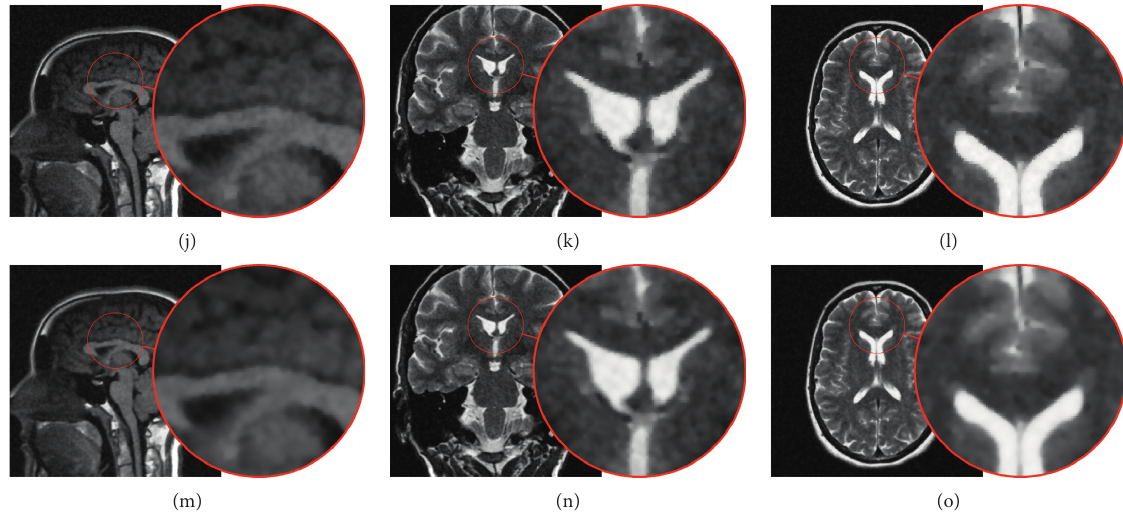
Figure 2: Visual comparison on different actual MRI scans corrupted by zero-mean white Gaussian noise with σ 2 � 0 . 015 and restored from various methods. (a) Original: patient 30. (b) Original: patient 50. (c) Original: patient 55. (d) Noisy: patient 30. (e) Noisy: patient 50. (f) Noisy: patient 55. (g) Wang–Zhou: patient 30. (h) Wang–Zhou: patient 50. (i) Wang–Zhou: patient 55. (j) Maiseli: patient 30. (k)